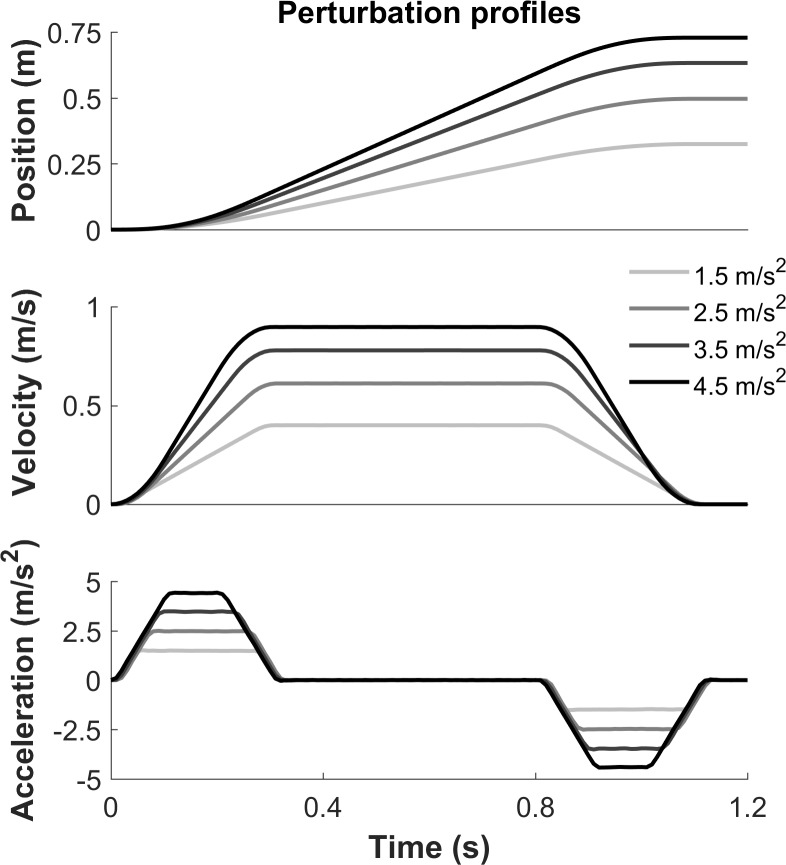
Perturbation profiles.Perturbation profiles for the different intensities of perturbation.